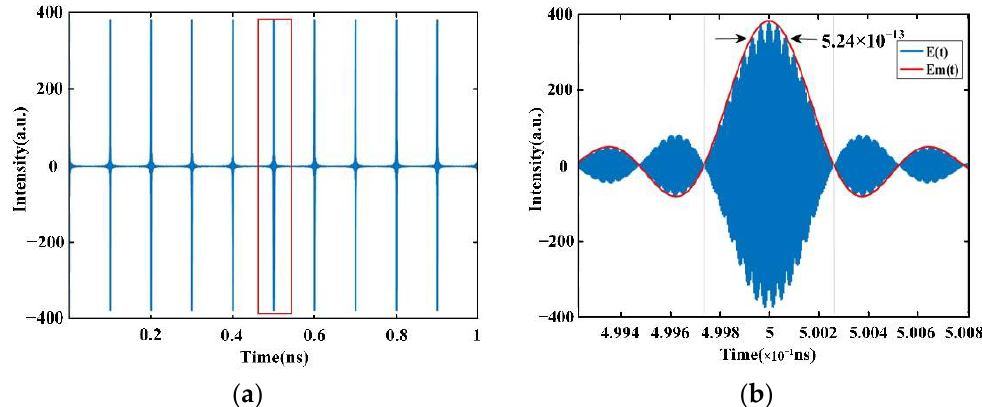
Figure 1. Simulated signal of OFC in the time domain: ( a ) a simplified model of OFC ( M = 381, f r = 10 GHz, f c = 194.2 THz) and ( b ) simulated signal of OFC of one period in the time domain.